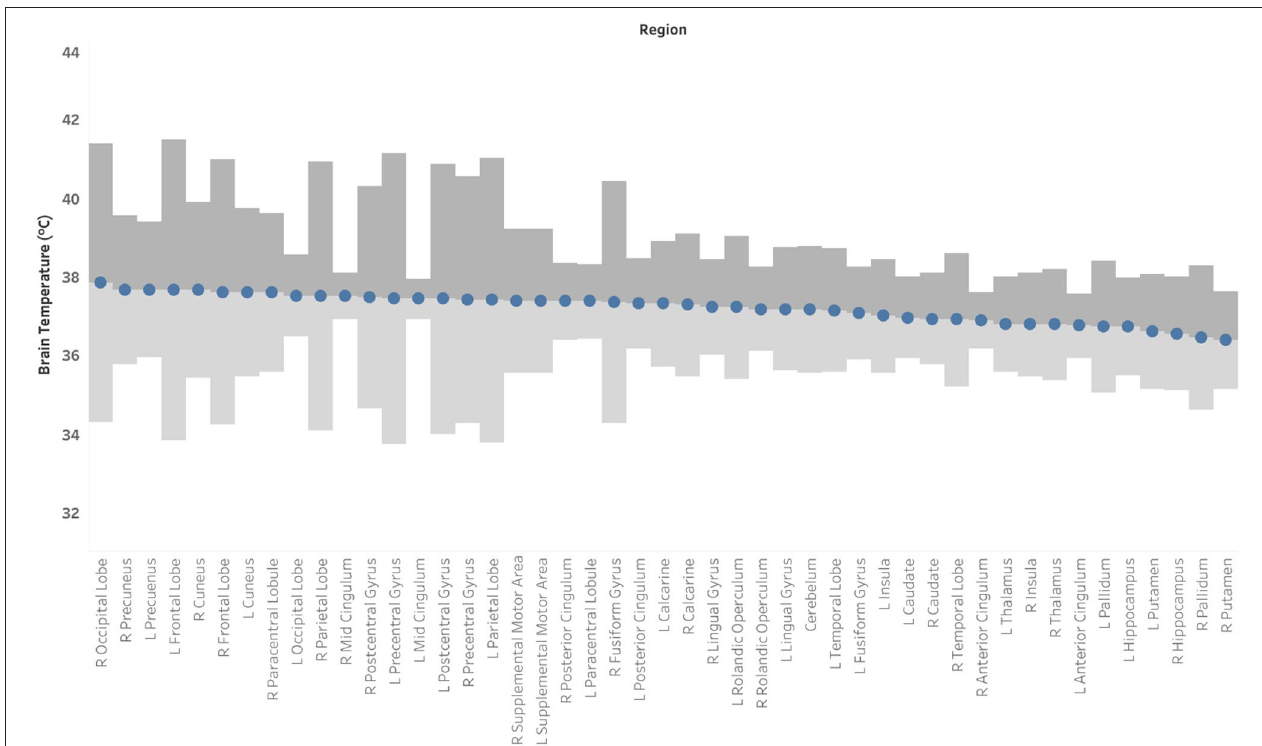
FIGURE 4 | Mean brain temperature for 47 brain regions delineated by the Automated Anatomical Labeling (AAL) atlas, with estimates of the upper and lower bounds of Minimal Detectable Change (MDC) at which temperatures may be above- or below-typical, respectively. Brain temperature was non-invasively derived from volumetric magnetic resonance spectroscopic imaging (MRSI) data. Voxel-level brain temperature was calculated according to the following equation: T CRE = − 102.61( 1 H20 − CRE ) + 206.1 ◦ C, where 1 H20 − CRE = chemical shift difference between the creatine and water resonances. The upper bounds of MDC are indicated in dark gray bands, and the lower bounds of MDC are indicated in light gray